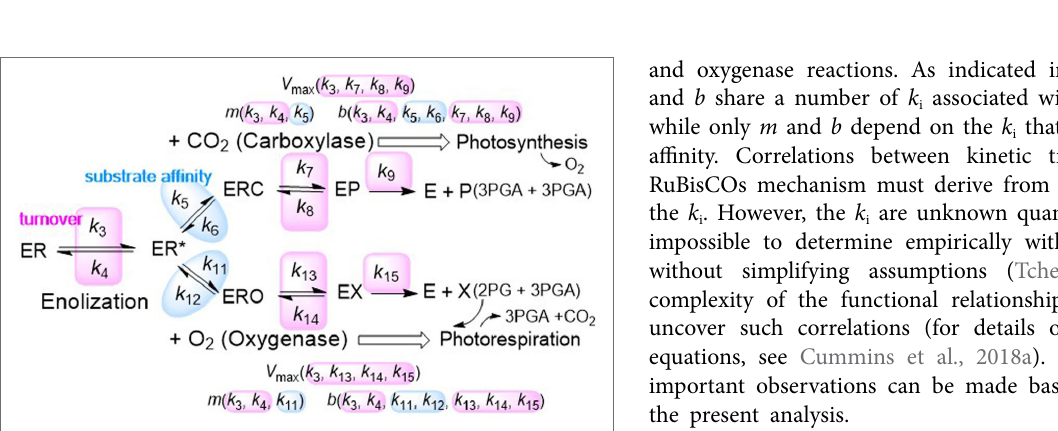
FIGURE 6 | The kinetic mechanism of RuBisCO. RuBisCO processes the three substrates, ribulose-1,5-bisphosphate (RuBP), and CO 2 or O 2 , the complete reactions taking place over several stages. RuBP (R) binds first, forming a complex (ER) with the activated form of the enzyme (E), followed by enolization of RuBP (ER*) which facilitates binding with the CO 2 (C) or O 2 (O) molecule to R* forming the ERC or ERO enzyme-substrate complexes. The 6-carbon compound formed by the addition of carbon dioxide to RuBP breaks apart forming a product complex (EP) which dissociates into two molecules of the 3-carbon compound (P), 3-phosphoglyceric acid (3PGA). Oxygenation proceeds through analogous steps except that the dissociation products (X) are one 3PGA molecule and one of 2-phospho- glycolate (2PG) to be recycled into 3PGA by photorespiration, producing CO 2 which can be made available for photosynthesis. The rate constants can be associated with turnover of product or affinity of CO 2 or O 2 substrate molecules for RuBP. The functional dependence of V max , m and b in K M (Equation 3) on the elementary rate constants is indicated for each of the reactions. A derivation of the actual kinetic equations is given in the Supplementary Material